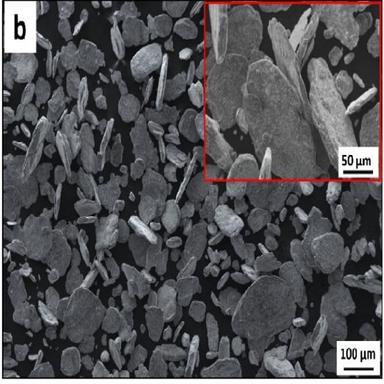
SEM image of the (a) as-received s-Cu powders and (b) f-Cu powders obtained by milling of s-Cu powders for 2h.